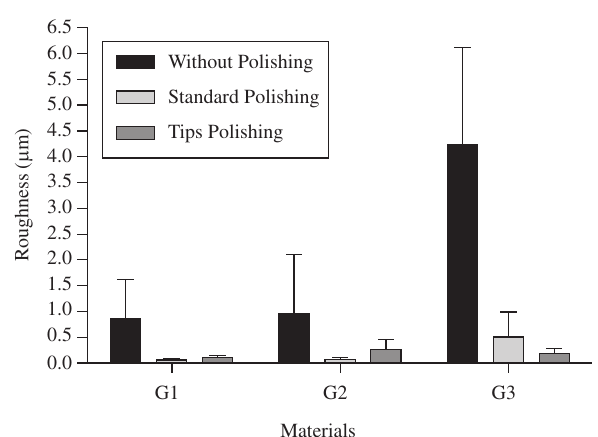
Figure 1. Mean values and standard deviation of surface roughness (µm) of the materials studied.